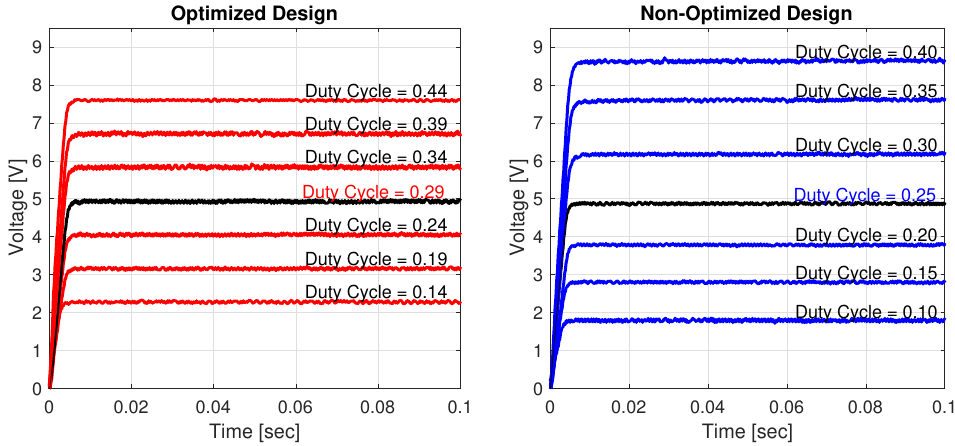
Figure 26. Output voltage of the Simscape model against the real optimized converter in nominal